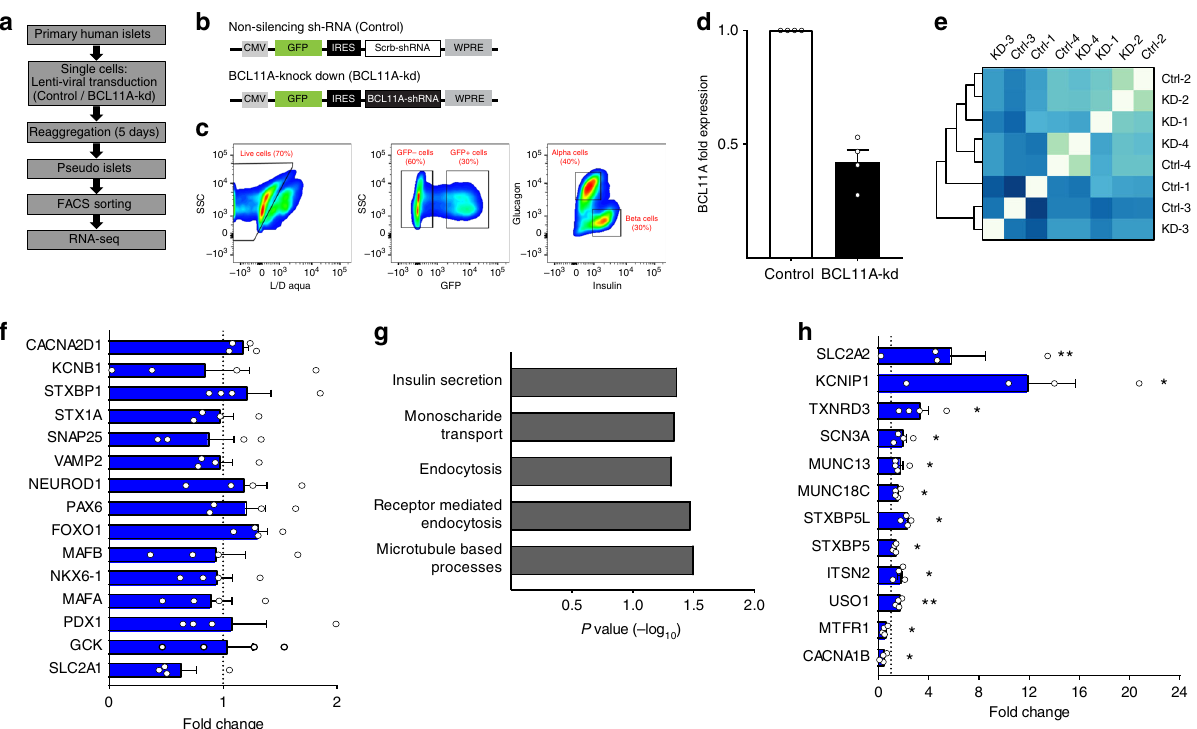
Fig. 4 beta cell BCL11A regulates multiple pathways associated with human insulin secretion. a Work fl ow employed to generate RNA-seq libraries. b Schematics of lentiviral construct used to knockdown BCL11A expression. c FACS scheme used to obtain GFP expressing beta cells. d BCL11A mRNA expression in GFP expressing beta cells post FACS, control (white bar) or BCL11A-kd (black bar) ( n = 4). e Pearson correlation coef fi cient matrix of all RNA-seq samples used in this study. f Fold transcript levels of genes critical for the maintenance of beta cell identity and function ( n = 4). g GO terms enrichment in genes mis-regulated in beta cells post-BCL11A knockdown. h Fold transcript levels of genes signi fi cantly altered in beta cells post-BCL11A knockdown ( n = 4). See also Supplementary Figure 4. The data presented as mean, error bars represent the standard error, and two-tailed t tests were used to generate p values. * p < 0.05, ** p <